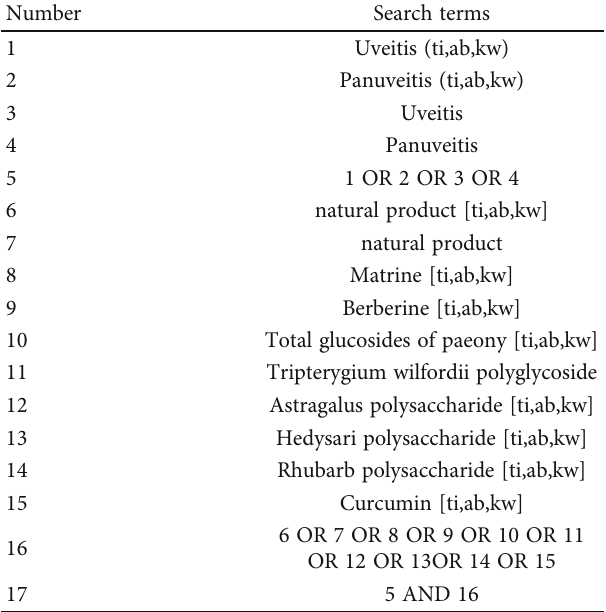
Table 2: Search strategy in EMBASE.